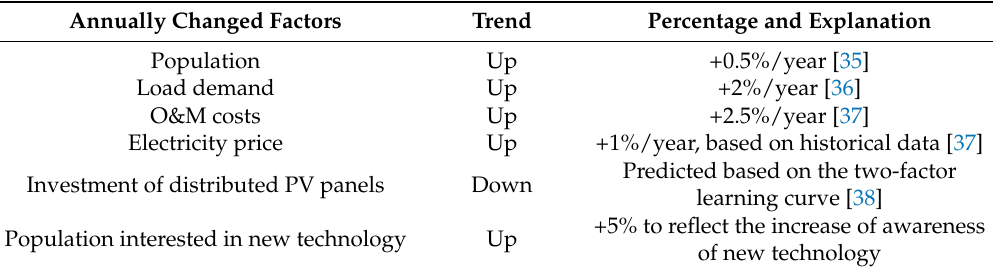
Figure 4. Interactions among multiple entities involved in the operation and planning of an ADN. Table 8. Variation in parameters during the